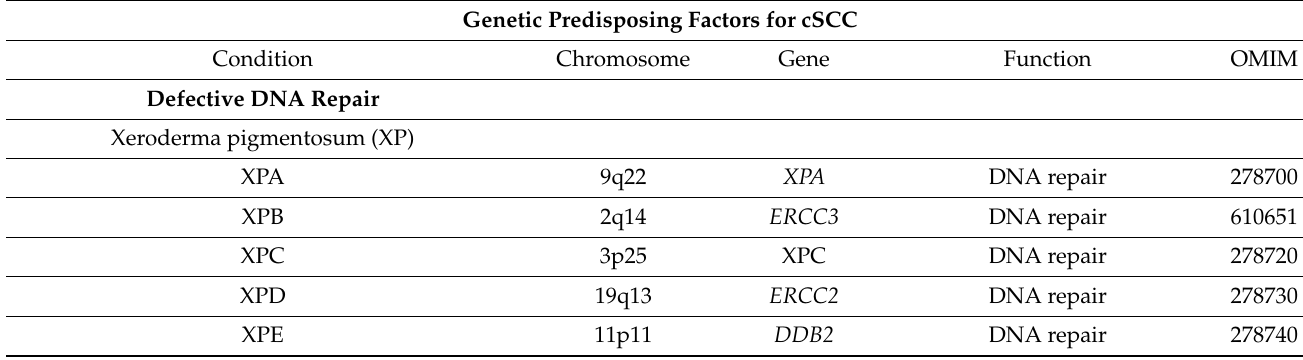
Table 2. Genetic predisposing factors of cutaneous squamous cell carcinoma. Genetically defined conditions are listed. Genetic Predisposing Factors for